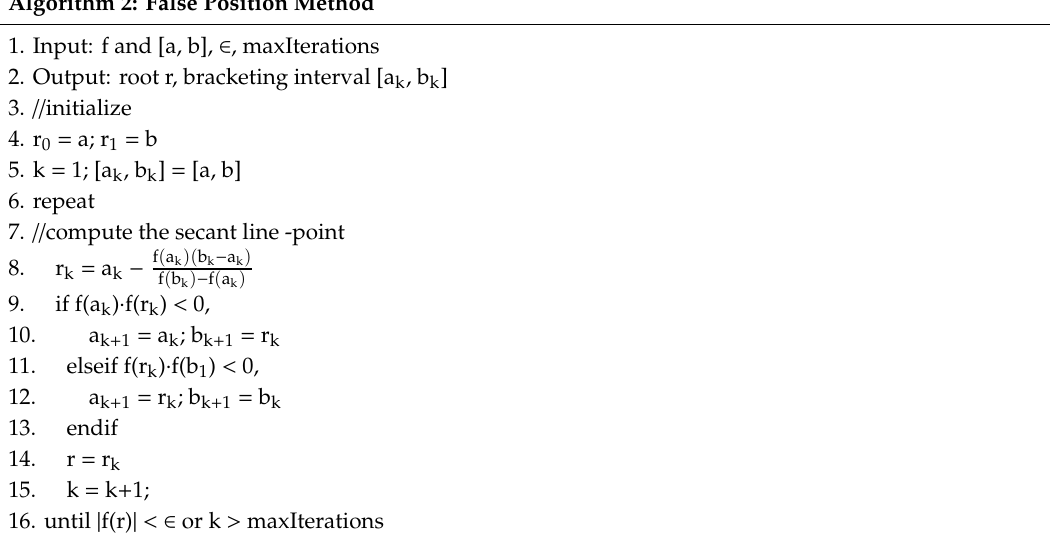
Figure 4. Convex function concave down, left endpoint fixed.